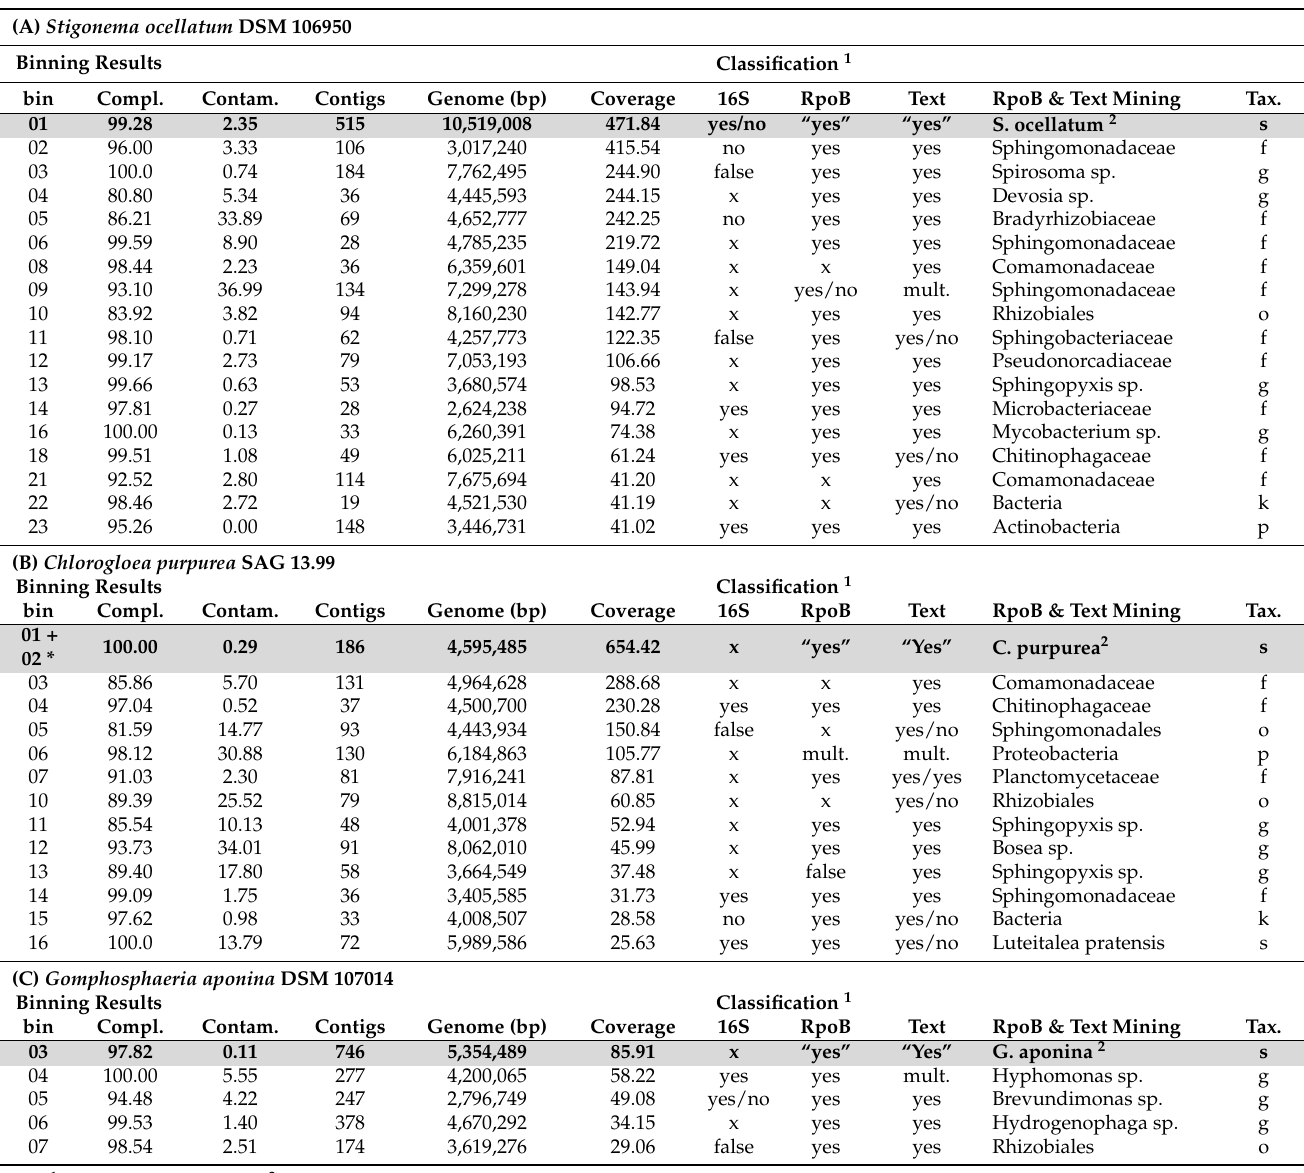
Table 4. Metagenomic binning of three non-axenic cyanobacteria and taxonomic classification. 36 bins with a completeness of >80% and a coverage >25-fold are shown. Cyanobacterial bins are highlighted in bold and